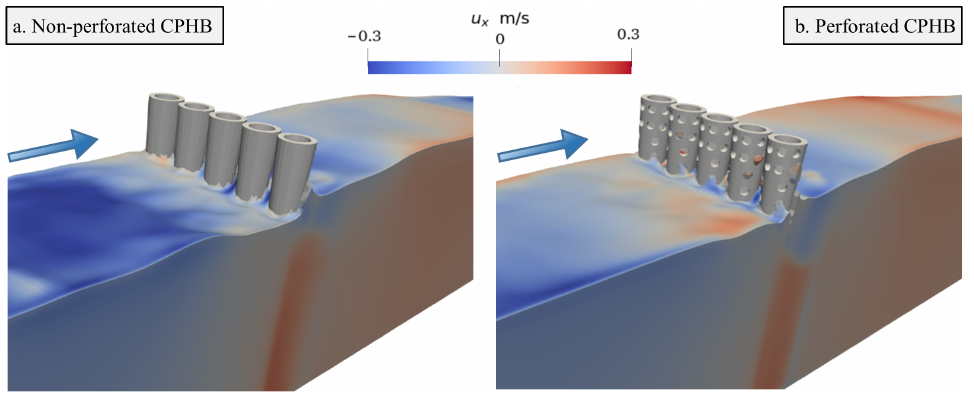
Figure 14. Simulated free surfaces of non-perforated and perforated CPHB cases with velocity magnitude